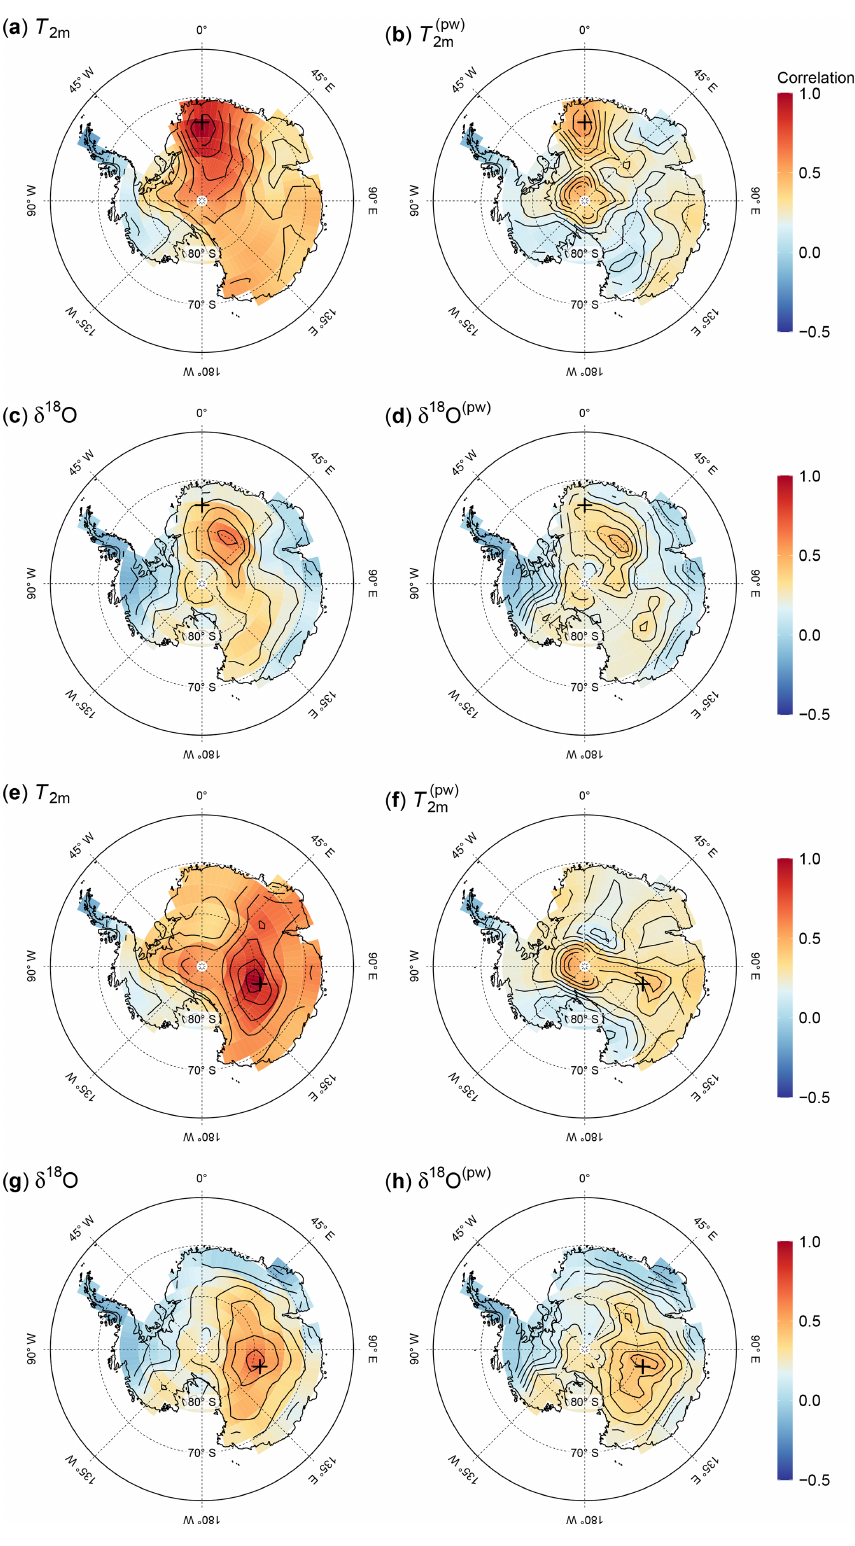
Figure 3. Spatial correlation with the temperature at the EDML and Vostok target sites. Shown are the correlations of the T 2m time series at the target sites EDML ( a – d ) and Vostok ( e – h ) with the spatial fields of temperature ( a , d ), precipitation-weighted temperature ( b , f ), oxygen isotope composition ( c , g ), and precipitation-weighted oxygen isotope composition ( d , h ). The target sites are marked with a black cross; black lines indicate correlation contour lines incremented in steps of